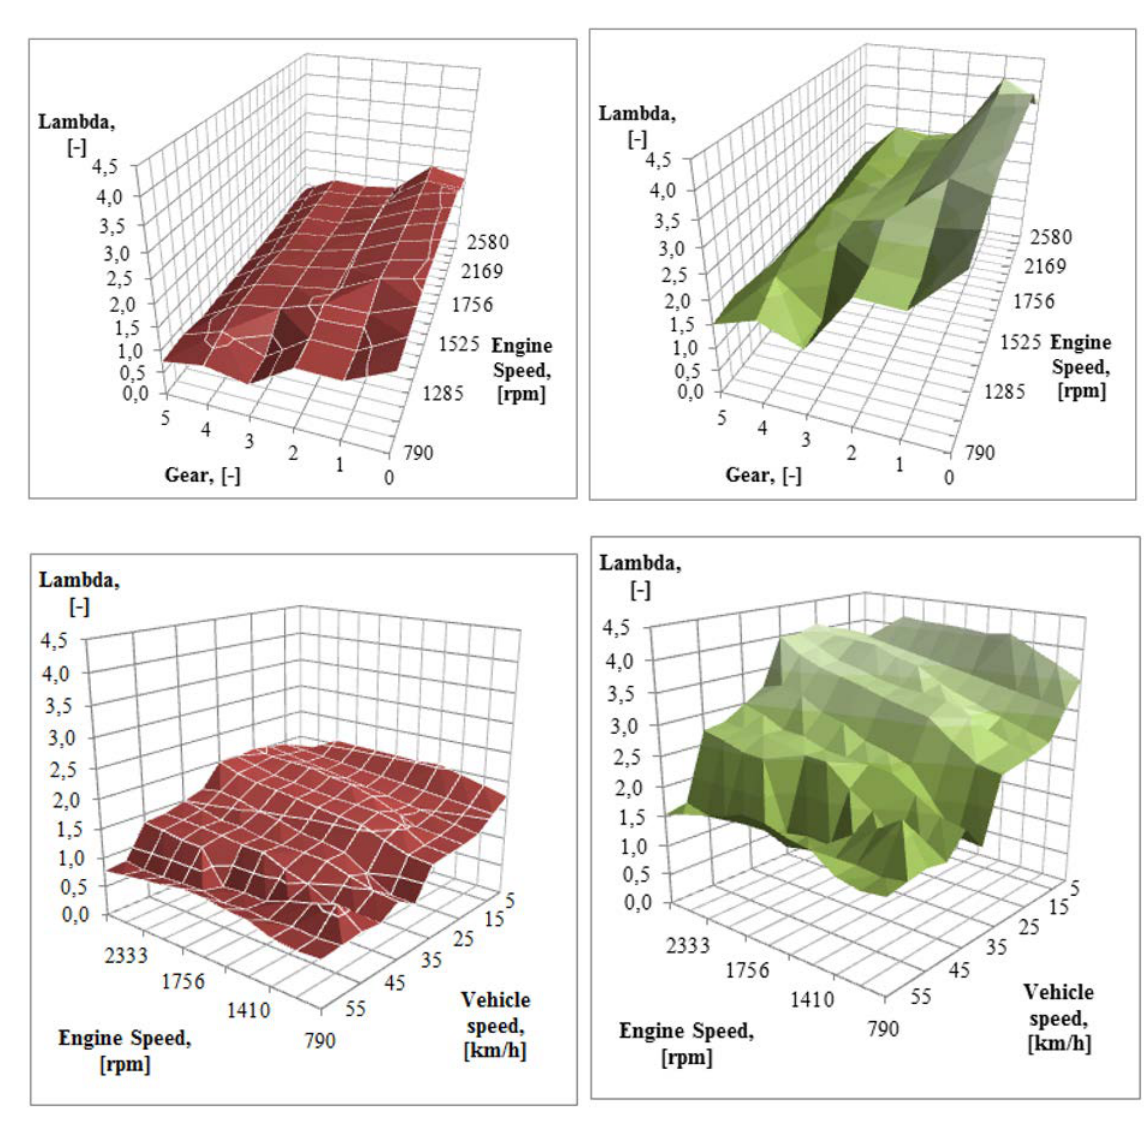
Figure 17. Lambda value during the experimental determinations. a. Lambda versus engine speed for different gear ratios in standard operating conditions; b. Lambda versus engine speed for different gear ratios with IAP operation; c. Lambda versus engine speed for different vehicle speeds in standard operation; d. Lambda versus engine speed for different vehicle speeds with IAP